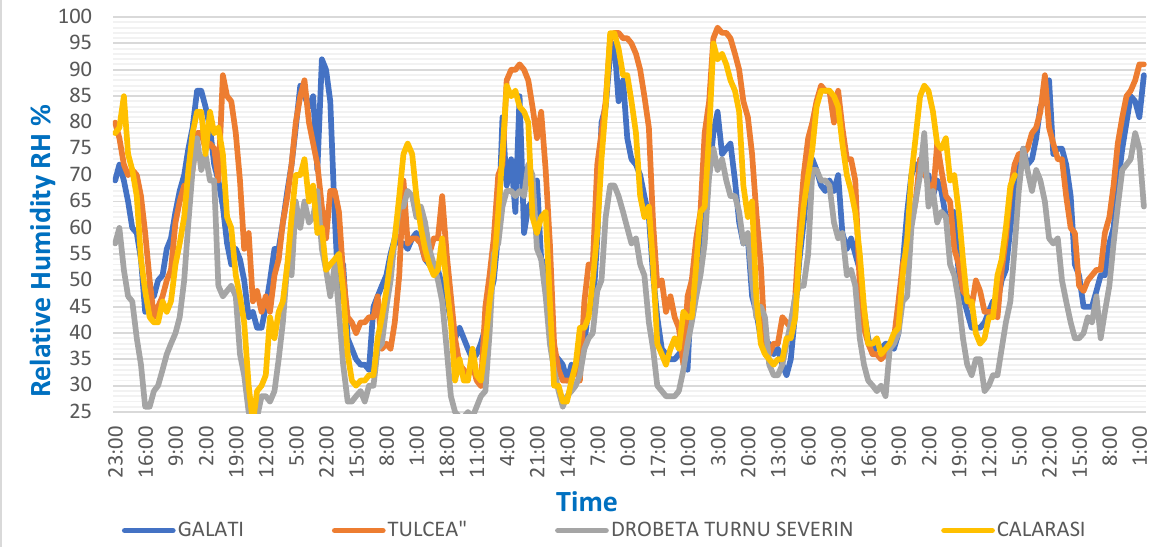
Figure 3. Time series of relative humidity 21-30th July 2021 (data processed from reference [33]).